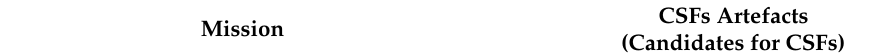
Table 1. Design of CSFs: Illustration of Stage 3. Mission